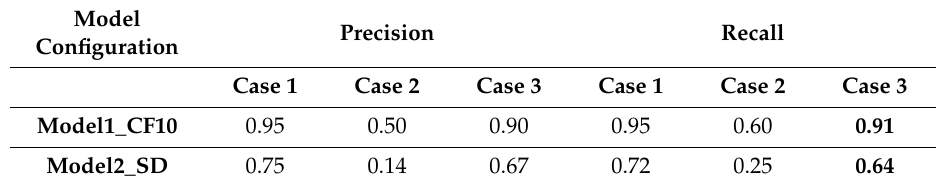
Table 5. Precision and recall for the CIFAR10 and ISIC skin disease data streams under di ff erent